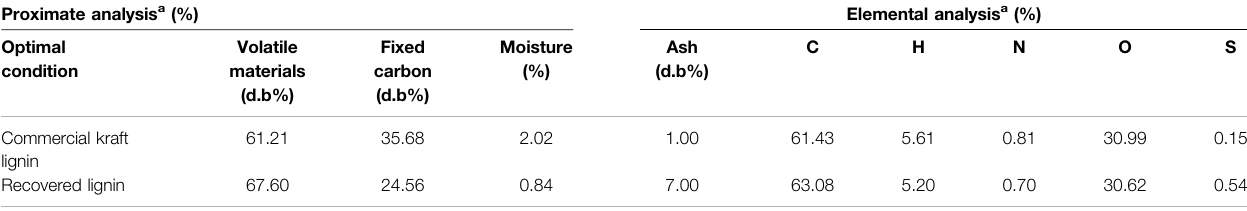
TABLE 4 | Proximate and elemental analysis of the commercial kraft lignin and recovered lignin. Proximate analysis a